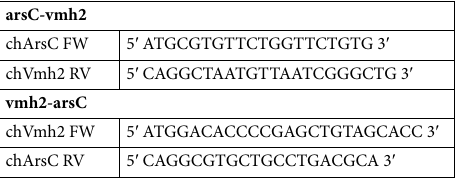
Table 2. Primers employed for PCR